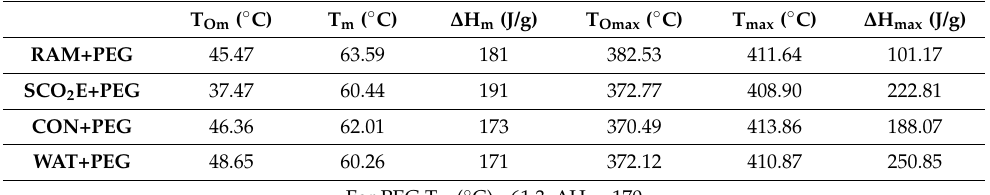
Figure 5. DSC (Differential scanning calorimetry (DSC) and TGA (thermogravimetric analysis) of PEG microparticles of pigments of raw algal materials or extracts obtained with different extrac- tion techniques: Sample 2: RAM+PEG — raw algal material, Sample 5: SCO 2 E+PEG — extract ob- techniques: Sample 2: RAM+PEG—raw algal material, Sample 5: SCO 2 E+PEG—extract obtained with tained with supercritical extraction, Sample 6: CON+PEG — dry extract obtained with conventional supercritical extraction, Sample 6: CON+PEG—dry extract obtained with conventional extraction, extraction, Sample 7: WAT+PEG — dry extract obtained with ethanol/water extraction, PEG — poly- ethylene glycol. glycol. Table 2. Summary of thermal properties of algae microparticles. Table 2. Summary of thermal properties of algae